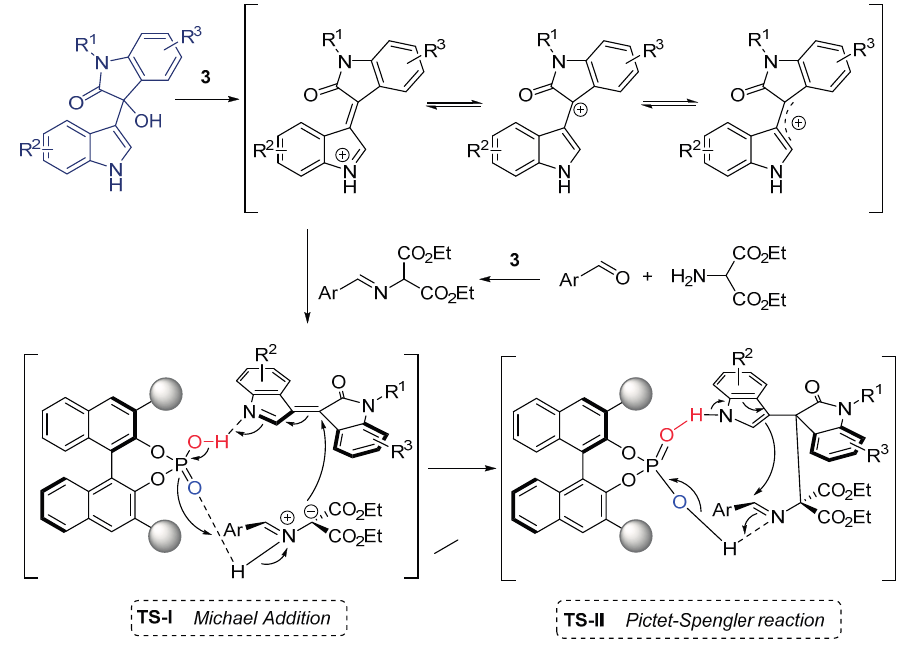
Figure 4. Proposed reaction mechanism and transition state